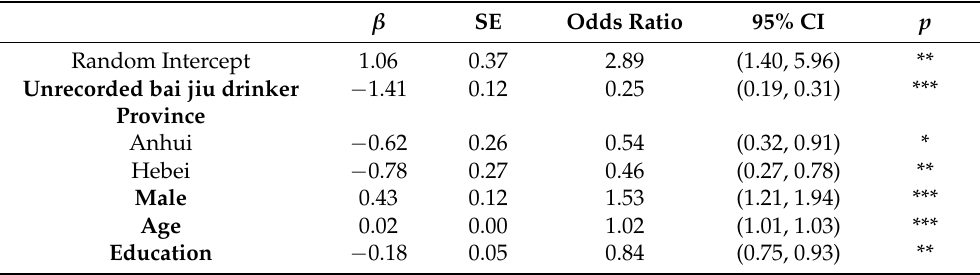
Table 7. Two-level logistic regression model of the effect of unrecorded bai jiu drinker and province on stability of alcohol type